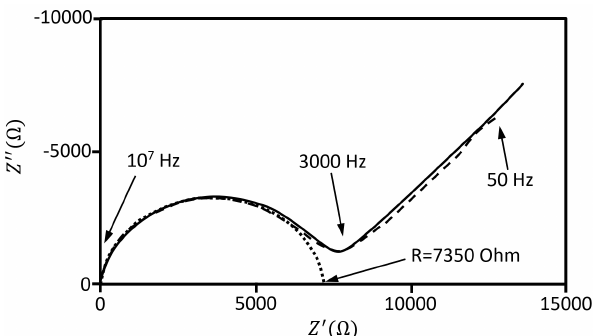
Figure 9. Typical complex impedance response of a Nafion membrane ( ϑ = 23°C, RH = 65%) with frequency range of 50–1 × 10 7 Hz. Dashed line: data from measurement; solid line: fitting of all measured points; dotted line: fitting of the first half-circle. The resulting ionic conductivity of the sample is 0.023S/cm. (based on the work in